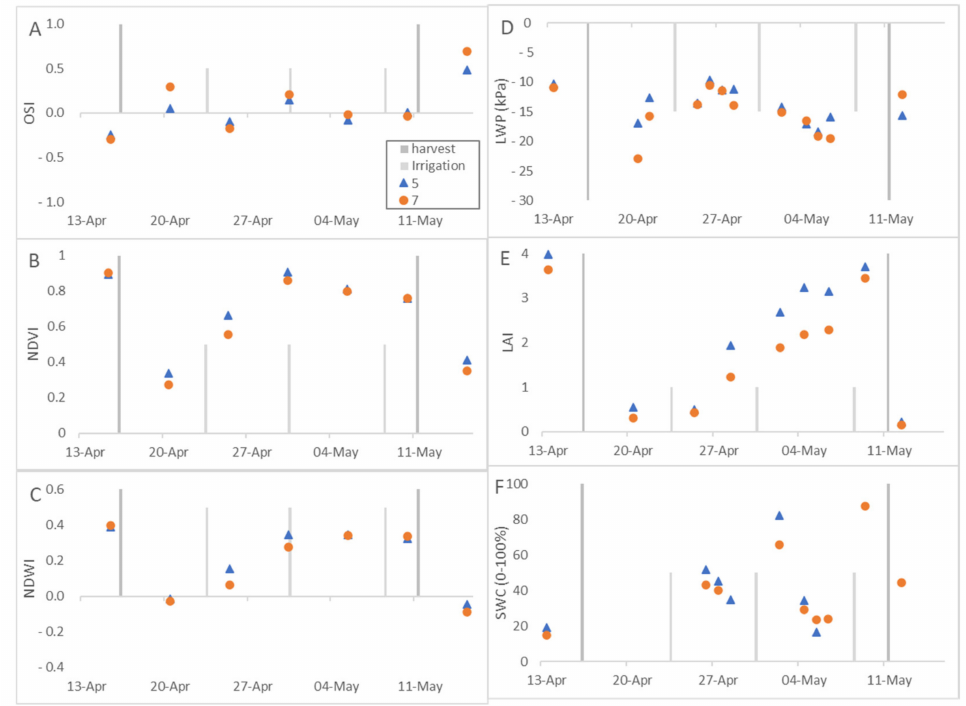
Figure 6. The spectral data ( A – C ) and crop measurements ( D – F ), sites 5 and 7, the second growth cycle.